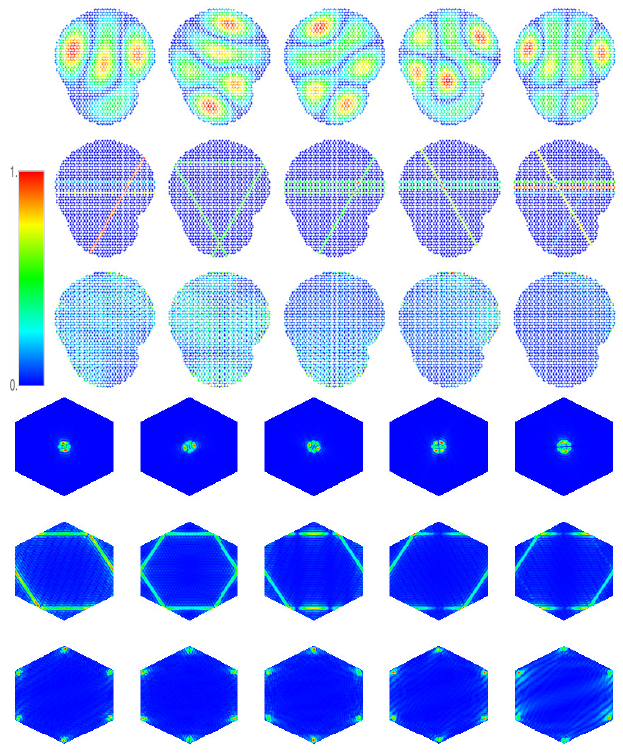
Figure 9. Hexagonal lattice with Africa shape with 1979 sites. Squared wave functions (three upper rows) and momentum distributions (three lower rows) of states ν = 6 − 10 at the lower band edge (first and fourth row, respectively), of ν = 736 − 740 around the lower van Hove singularity vHs − / at ν (cid:39) 738 (second and fifth row, respectively) and of states ν = 996 − 1000 around the DP at ν = 990 (third and sixth row,